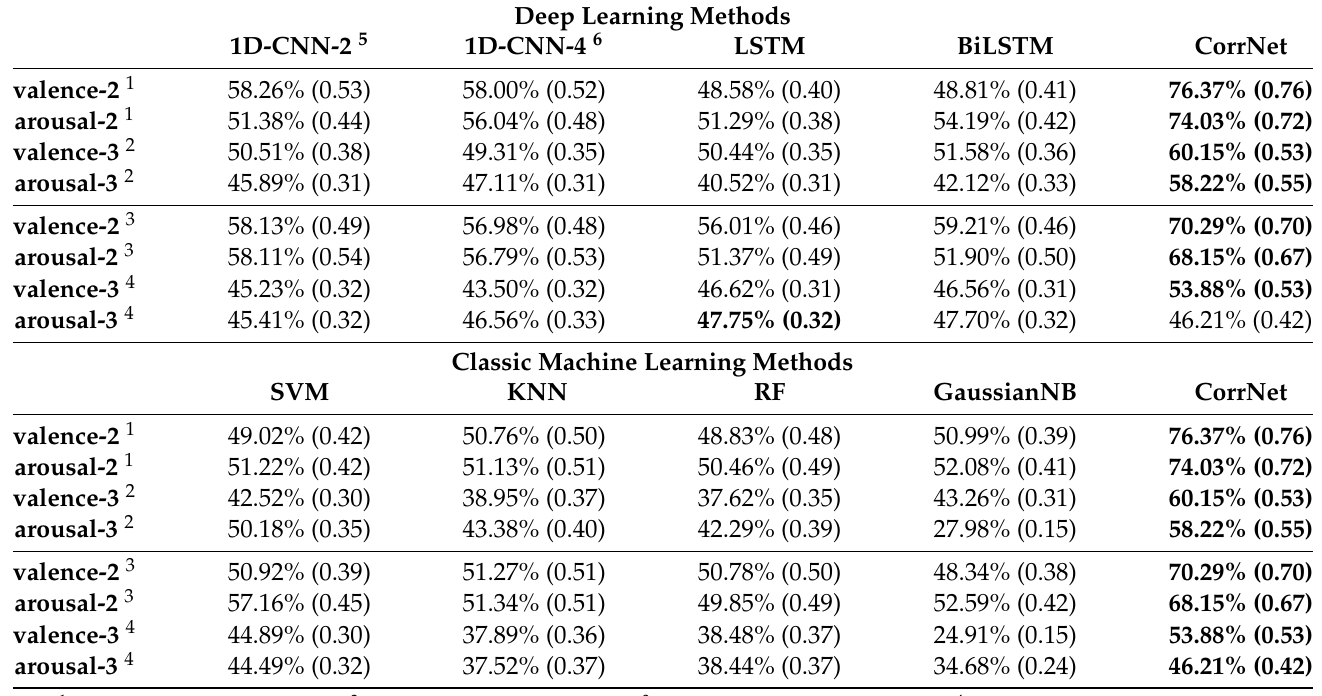
Table 5. Comparison between ML, DL methods and CorrNet using LOSOCV (accuracy (W-F1)).